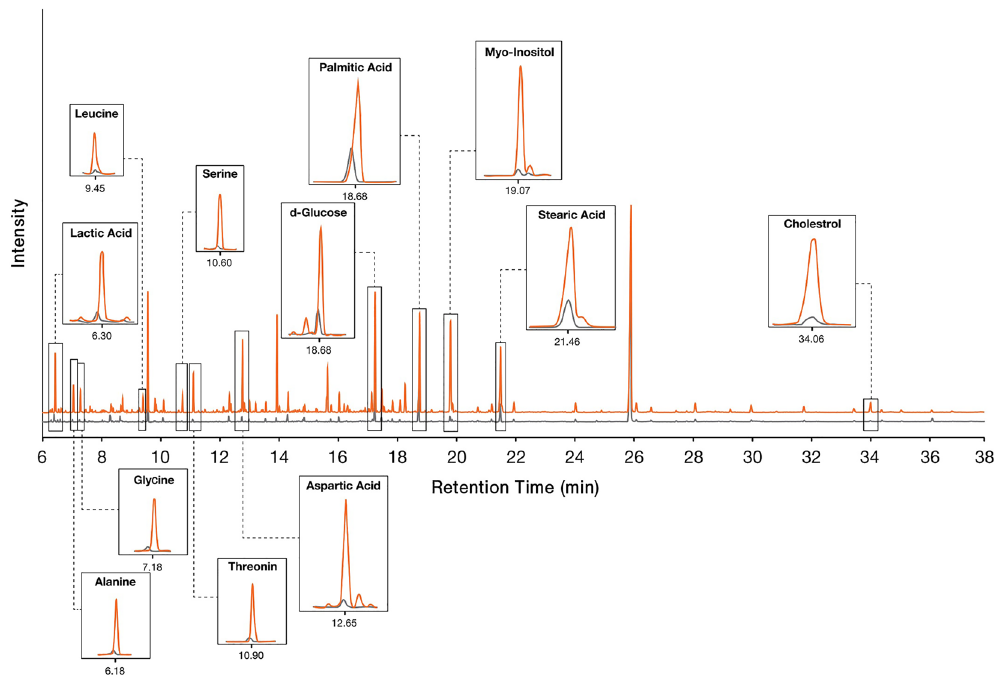
Figure 3. Cisplatin-treated PGCC-enriched cells have a distinct metabolic profile. The metabolome of cisplatin- treated (orange peaks) and untreated bladder cancer cells (gray peaks) were assessed by gas chromatography- mass spectrometry